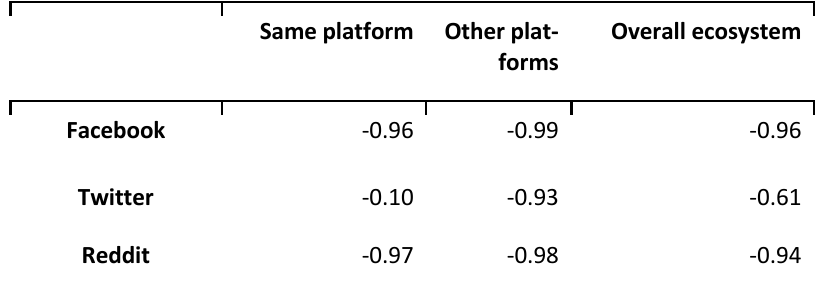
Table 2. Change in the probability that a submission containing a URL will lead to the creation of another submis- sion containing the same URL between unmoderated and moderated content. The change is given for submissions on the same platform, between platforms, and in the total